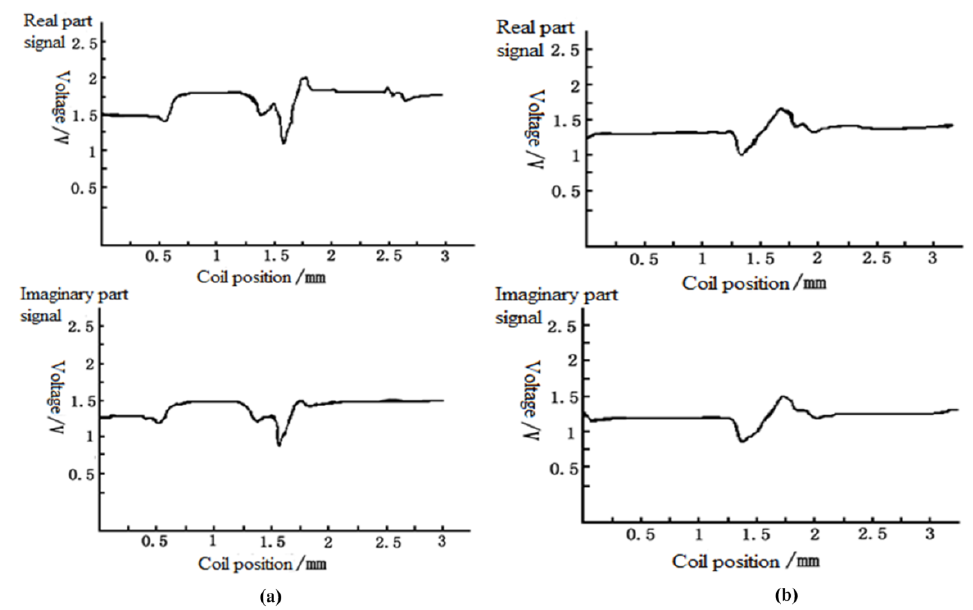
Figure 1. Signals obtained in the presence and in the absence of girth weld defects. ( a ) Eddy current testing (ECT) signal in the presence of the girth weld defects. ( b ) Original signal of the girth weld.